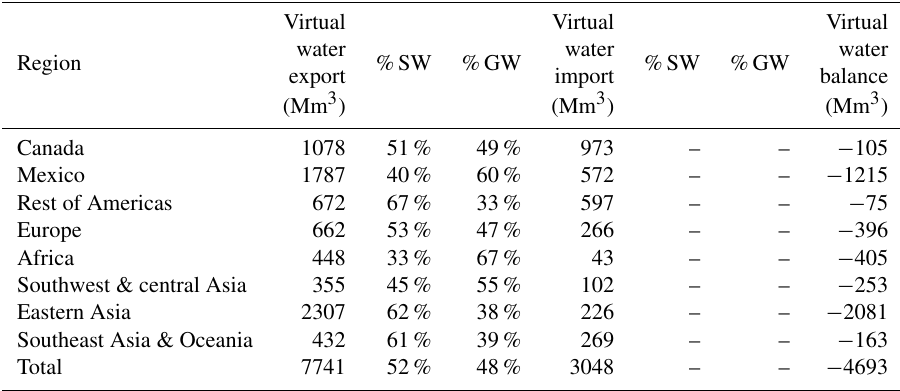
Table 5. US blue virtual water exports and imports to and balances with world regions.